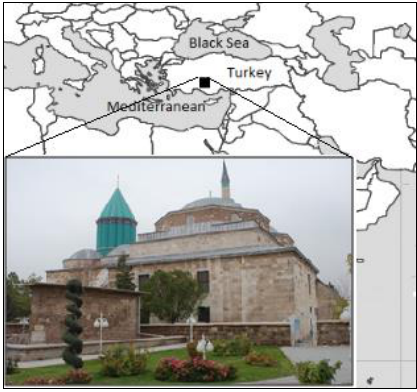
Figure 1. Mevlana Museum.